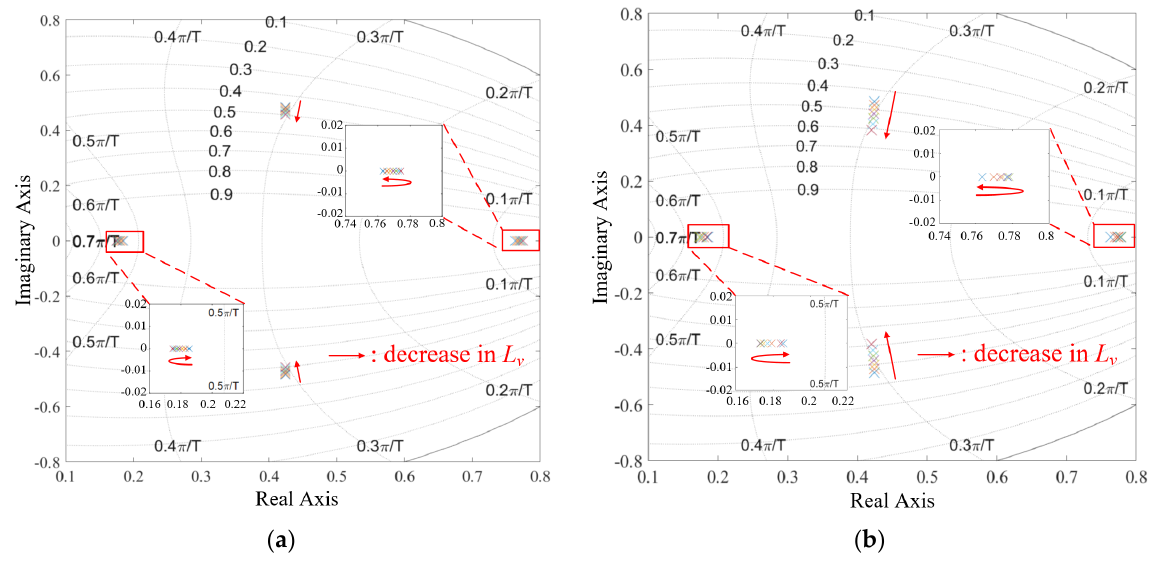
Figure 9. Pole loci of the proposed method with different virtual impedance. ( a ) Pole distributions at 1000 rpm and ( b ) pole distributions at 3000 rpm.